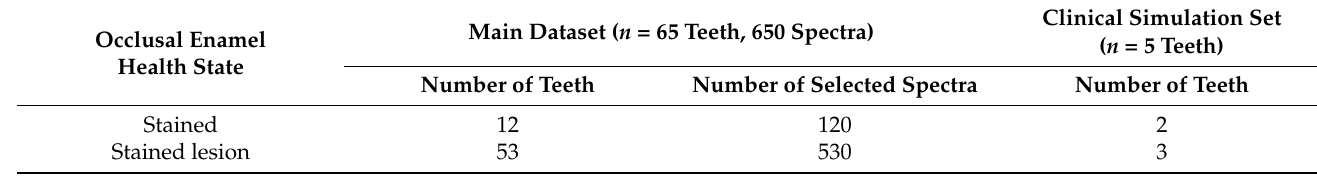
Table 1. Distribution of analyzed samples in this study. From each of the 12 stained but intact and 53 stained lesion samples, 10 fissural enamel spectra were selected for classifier training and validation. To simulate the classifier’s application as a clinical decision-support system, an additional two stained but intact and three stained lesion samples were